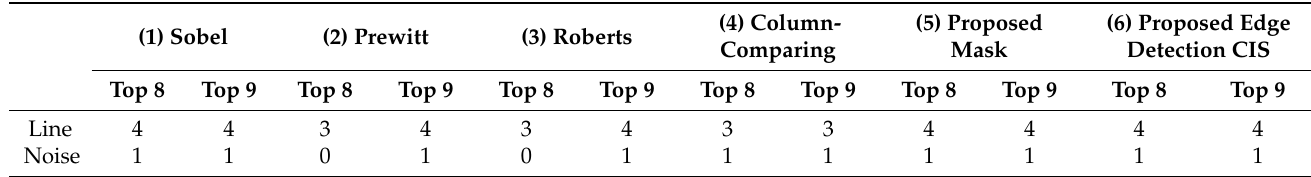
Table 3. Degree of lane recognition of an image that ended the lane recognition (= how many of four center lanes are